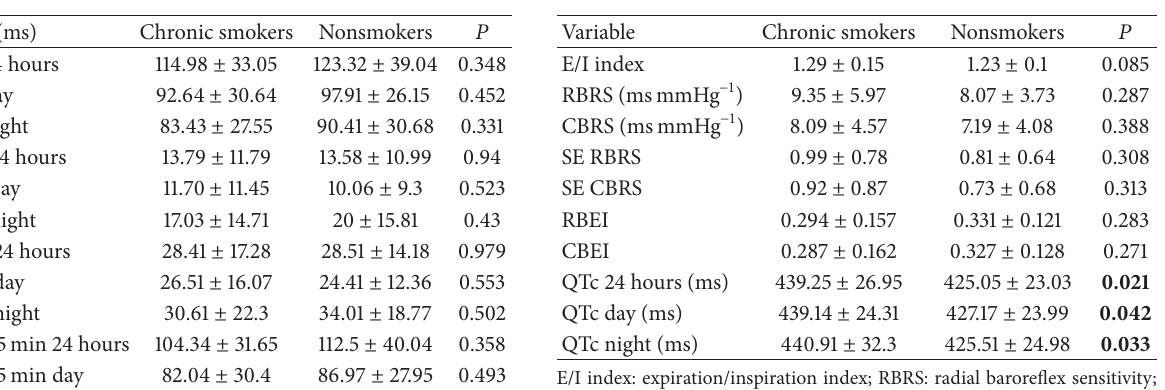
Table 4: Mean values ( ± SD) of E/I index, BRS measurements, and QTc interval duration during 24-hour, day, and night